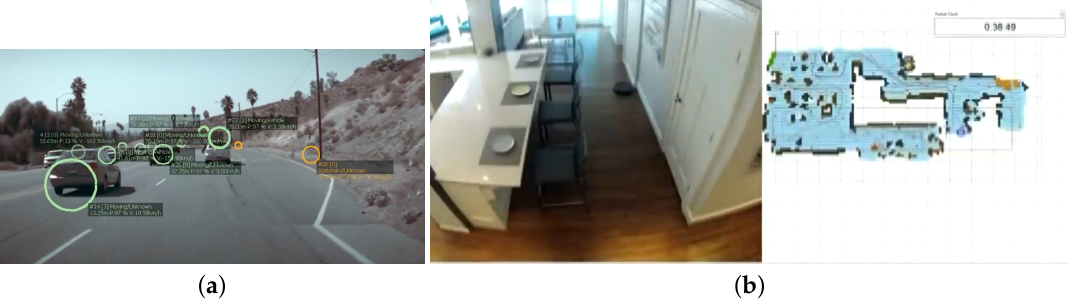
Figure 1. ( a ) Tesla AutoPilot system, ( b ) Roomba 980 vision